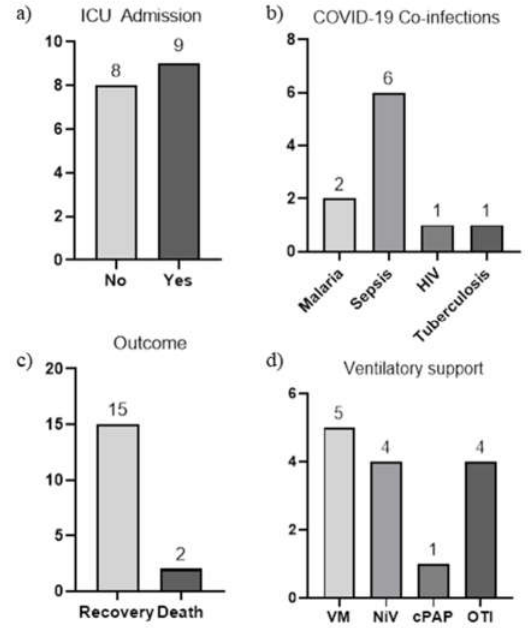
Figure 1. ( a ) Number of patients admitted to ICU; ( b ) Types of coinfections; ( c ) Clinical outcome; ( d ) Types of ventilatory support administered.